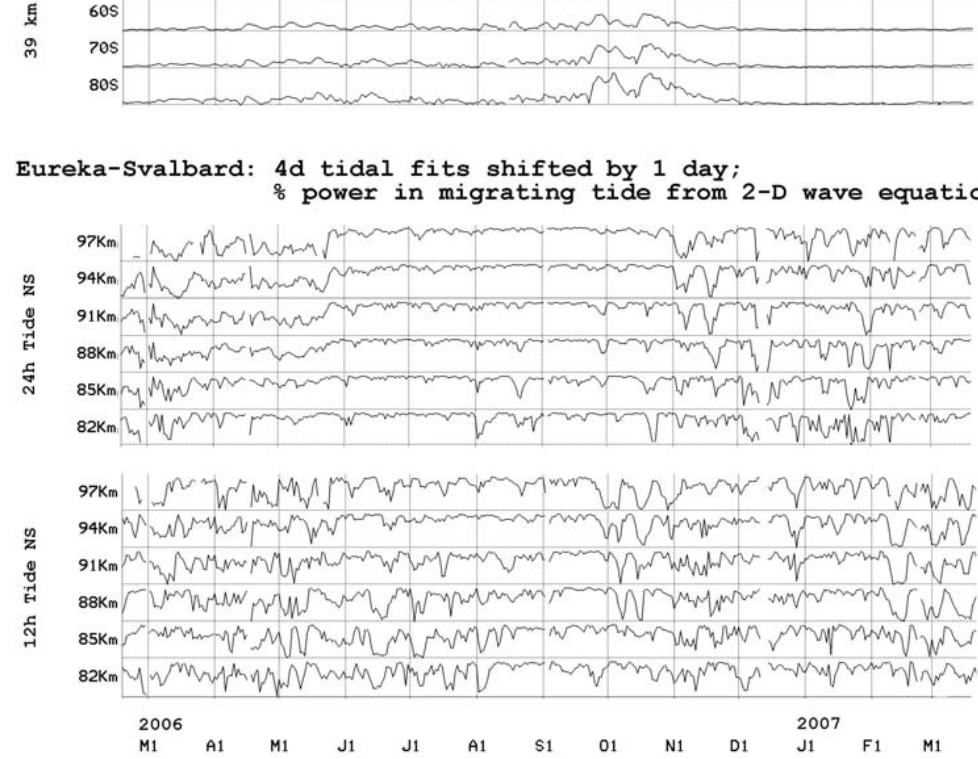
Fig. 12. Time-sequences of the amplitude, obtained from the Fourier transform, for the SPW S =1 (80m/s for each height-box/sequence): in this case the NS component of the wind, at high latitudes of both hemispheres and at 39km, is shown. Below, and using the same analysis as used for Figs. 9 and 10, we show the % power in the MT when compared with the RMS of the observed tides at Eureka and